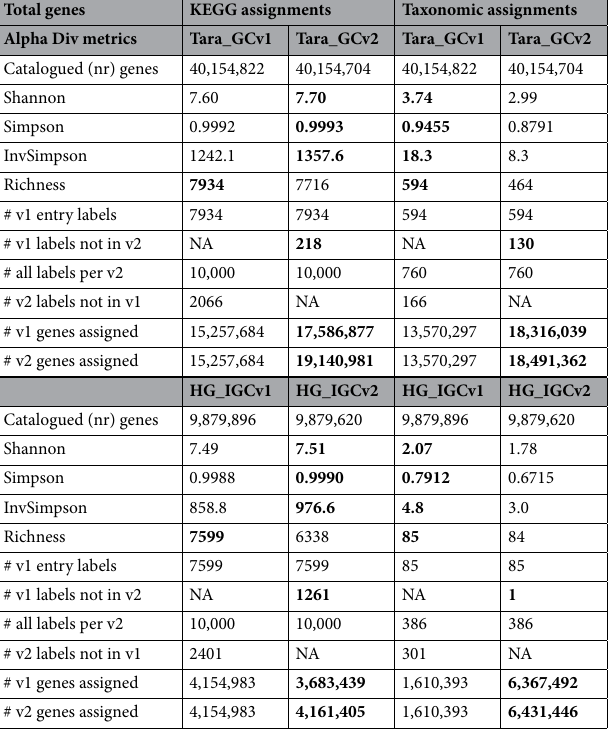
Table 1. Alpha diversity measures comparing original (v1) and re-annotated (v2) Tara Ocean and human gut microbiome (HGM) gene catalogs. Higher metrics are shown in